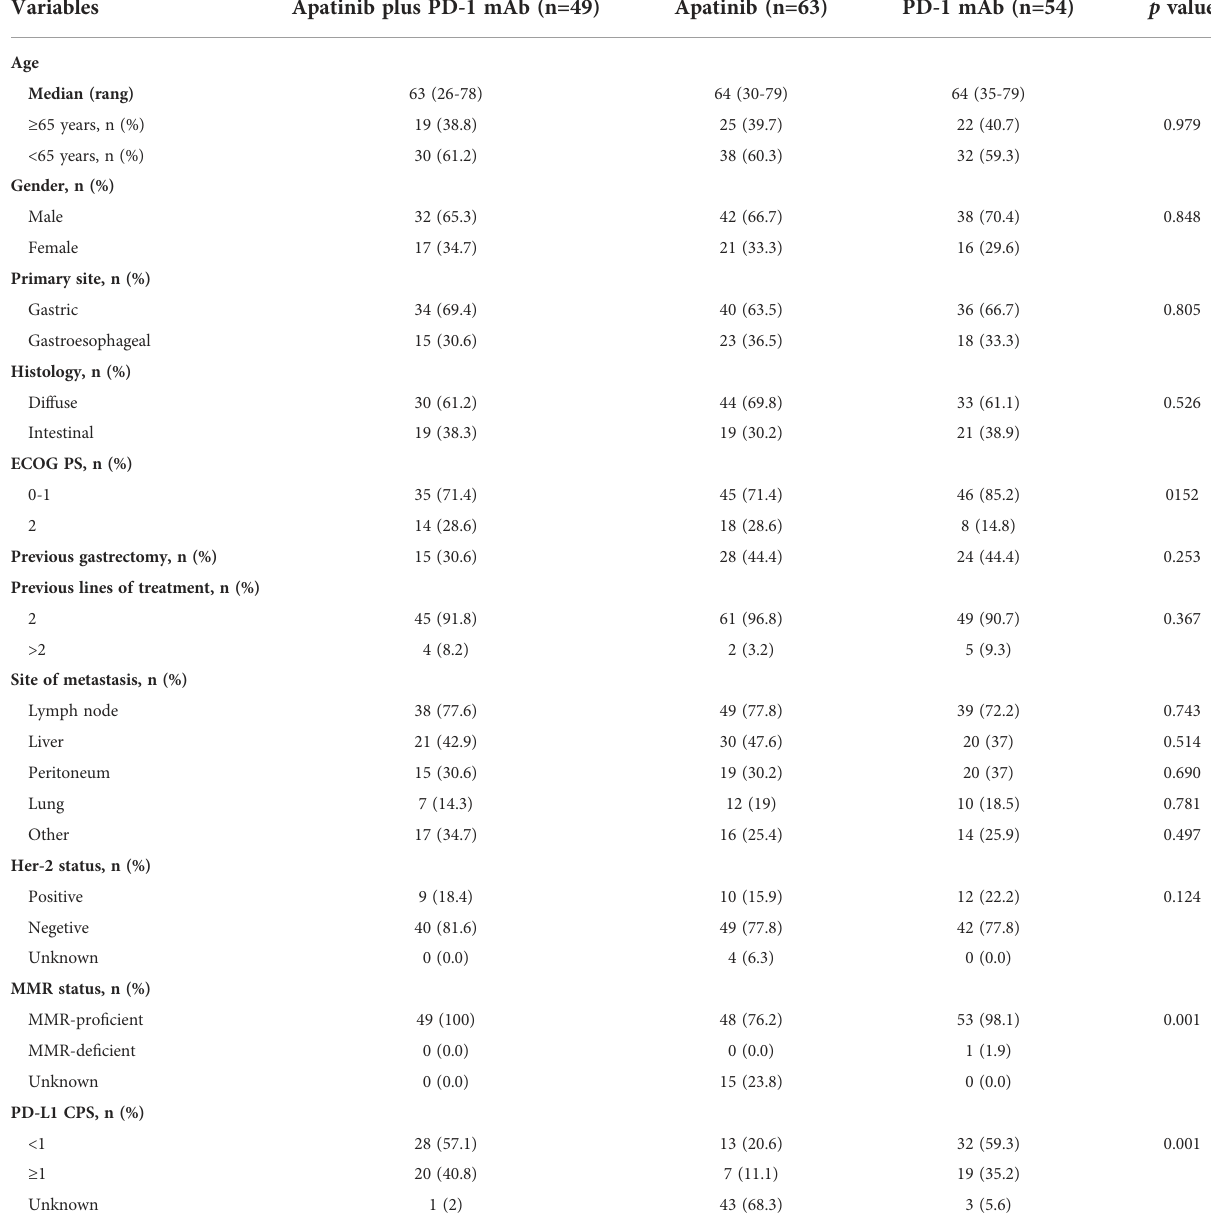
TABLE 1 Patient baseline